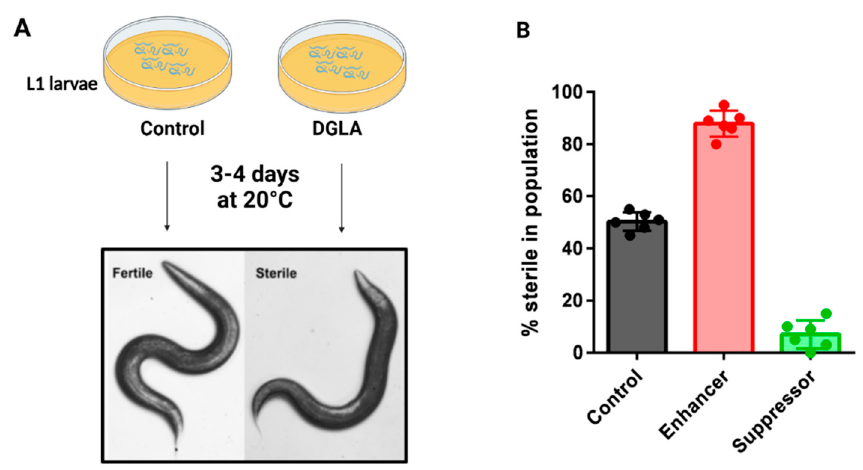
Figure 3. Dietary DGLA causes ferroptosis of germ cells and sterility in C. elegans . ( A ) Schematic of the C. elegans fatty acid supplementation assay. Synchronized L1 larvae are plated onto agar plates containing DGLA and dietary E. coli , and incubated at 20 degrees until they reach adulthood, when they are scored as fertile or sterile. Sterile worms lack gametes due to ferroptosis of germ cells during development. ( B ) Mutant strains that are more sensitive to DGLA are known as enhancers, while mutant strains that are less sensitive to DGLA are known as suppressors. Often, enhancer strains contain mutations in protective genes, such as genes encoding GPX enzymes or genes required for MUFA production. Suppressor genes include genes needed to produce membrane PUFAs, or mutants that confer increased stress responses.